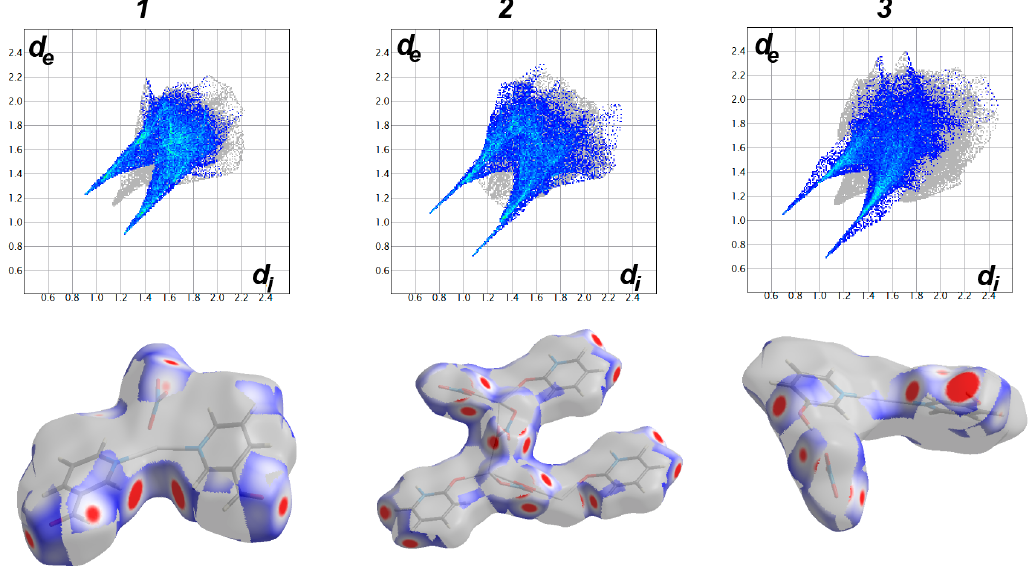
Figure 8. The fingerprint (upper) and d norm maps (lower) of the O…H contacts. Sharp spikes in the fingerprint plot and red spots in d norm maps are strong pieces of evidence on the importance of O…H contacts in the molecular packing.